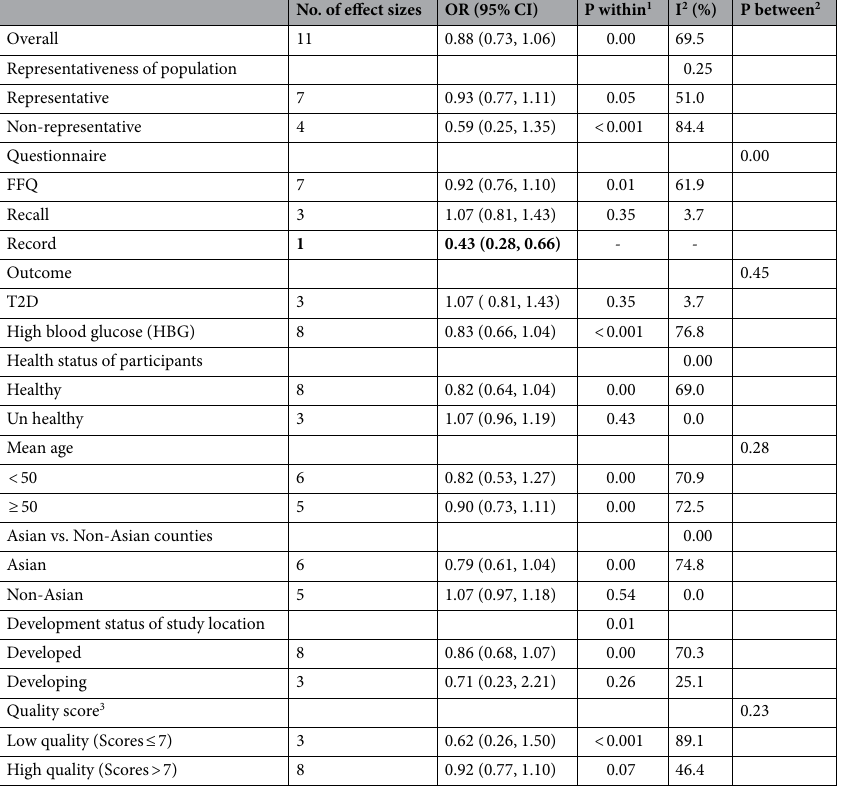
Table 4. Results of subgroup-analyses of dietary Ca intake in relation to T2DM/hyperglycemia in cross- sectional studies. 1 P for heterogeneity, within subgroup. 2 P for heterogeneity, between subgroups. 3 Quality Scores were according to Newcastle–Ottawa